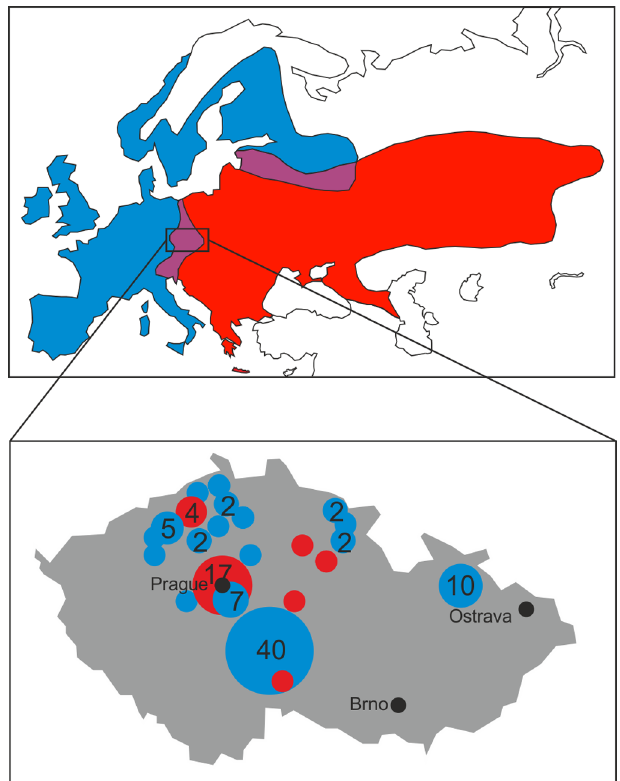
Figure 1. Distribution range map of Erinaceus europaeus (blue) and E. roumanicus (red) in the western Palearctic and their zones of sympatry (violet) as well as the origins of the hedgehog specimen from the Czech Republic used in this study. Size of circles represents the number of hedgehogs from the different locations (modified after [10]).